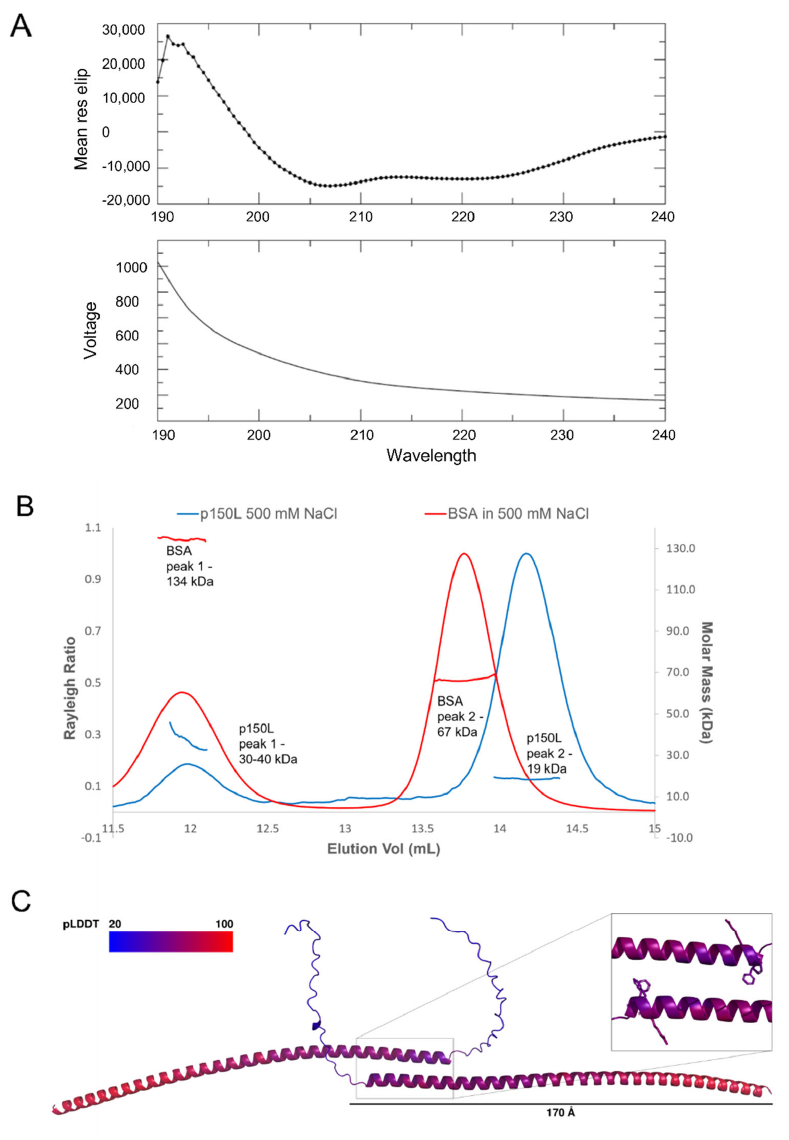
Figure 6. CD and SEC-MALS analyses of p150L. ( A ) The CD spectra indicate that CAF-1 p150L is composed mainly of α -helices. CD spectrum was acquired in 10 mM sodium phosphate, pH 7.2, 10 mM NaCl, and 0.1 mM TCEP buffer with a data pitch of 0.5 nm over a range from 260 nm to 190 nm. ( B ) SEC-MALS analysis. The p150L protein was injected onto a size exclusion chromatography column coupled to multi-angle light scattering to compute the molar mass and oligomerization status of the protein (blue trace). The principal peak of p150L corresponds to a monomer (19 kDa), whereas the minor peak may form a dimer (30–40 kDa). Relative to the larger 67 kDa BSA monomer (~13.7 mL, red trace), the early ‐ eluting position of the minor peak is indicative of a non ‐ globular shape. The dimeric configuration is most likely not a coiled ‐ coil due to the drastically different elution volume than the monomeric p150L. ( C ) AlphaFold ‐ Multimer predicts an elongated coiled ‐ coil arrangement of p150L. The models are colored by confidence (pLDDT) scores, and the RFF residues are shown as sticks. The scale bar is 170 Å. An unusually long α‐ helix (119 amino acids) is predicted to end abruptly in the PIP RFF residues. The CAF ‐ 1 p150 PIP is surrounded by a red rectangle. To address this sur ‐ prising prediction, CAF ‐ 1 p150 fragments that contained the predicted long α‐ helix in ‐ cluding the PIP were expressed in E. coli , purified, and their biochemical and biophysical properties were characterized. This fragment of human p150 (Figure 5, residues 342–474) was expressed as a His ‐ tagged fusion protein, hereafter referred to as CAF ‐ 1 p150L. De ‐ spite purification in the presence of 2.5 M NaCl, the CAF ‐ 1 p150L protein co ‐ purified with nucleic acid contamination. Further treatment with benzonase and three sequential 1 M NaCl washes were required to remove the contamination. 2.3.1. CAF ‐ 1 p150L Is Highly Helical Circular dichroism (CD) spectroscopy was used to determine whether purified CAF ‐ 1 p150L protein forms a long α‐ helix as predicted. The CD spectrum of CAF ‐ 1 p150L clearly showed features typical of a mainly helical protein (Figure 6A, upper panel), as shown by the strong negative molar ellipticity at 222 nm and 208 nm.